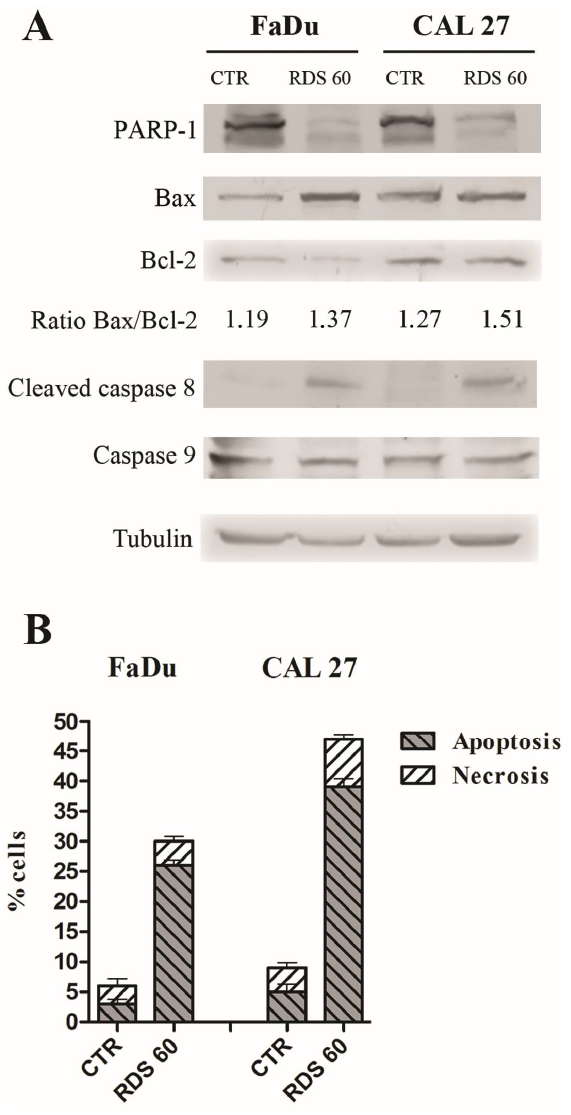
Figure 4. Apoptosis induced by RDS 60 in HNSCC cell lines. ( A ) Western blot of PARP-1, Bax, Bcl- 2, cleaved caspase 8 and caspase 9 from FaDu and CAL27 untreated (CTR) and 2 μM RDS 60 treated for 24 h. The means from densitometry quantifications of three different experiments of the Bax to Bcl-2 ratio normalized to tubulin are indicated. ( B ) Percentages of apoptotic and necrotic cells evaluated by annexin V-APC and 7AAD expression quantified by FACS on FaDu and CAL27